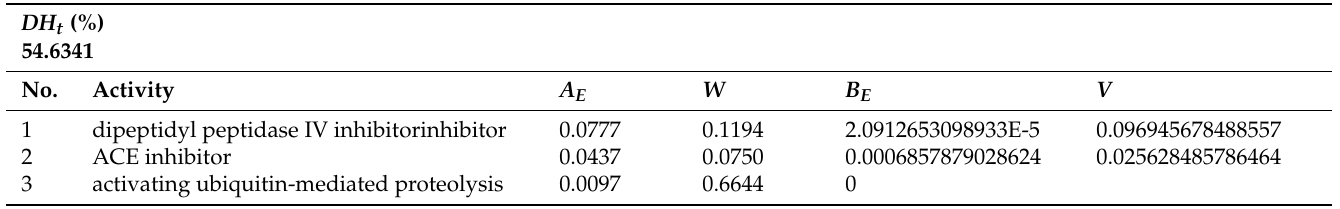
Table A10. A E , DH t , W , B E and V values from RubisCO of Halophila stipulacea . In silico enzymatic cleavage was carried out by pancreatic elastase.